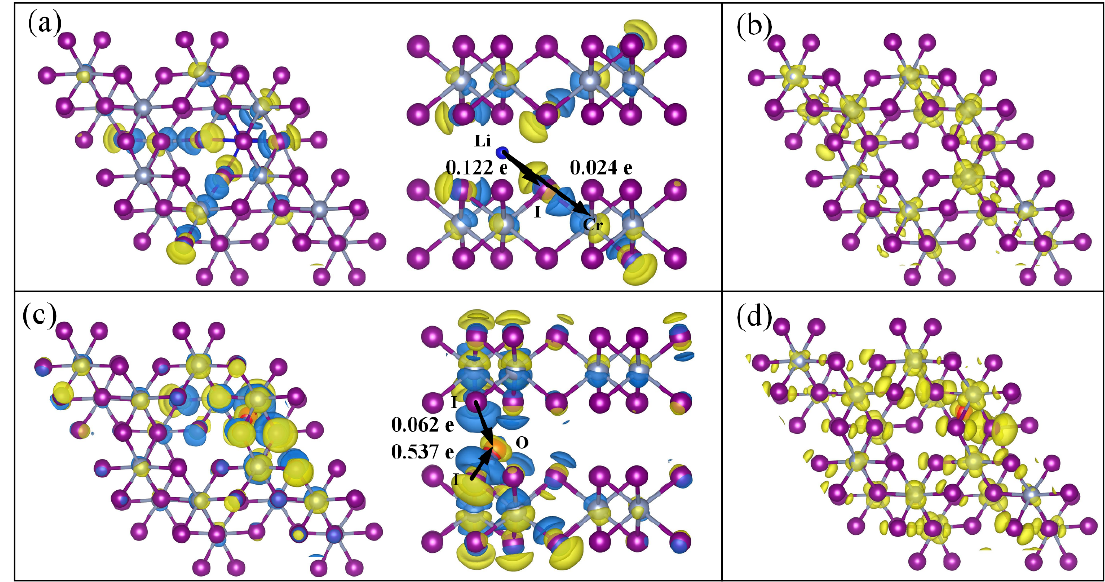
Figure 3. Differential charge density of ( a ) Li and ( c ) O intercalated 2 × 2 supercell. The isosurface value was 0.01 e/Bohr 3 , and the yellow (blue) isosurface contours indicate the charge accumulation (depletion). Band-decomposed partial charge density of ( b ) Li and ( d ) O intercalated 2 × 2 supercell, the isosurface value was 0.001 e/Bohr 3 .